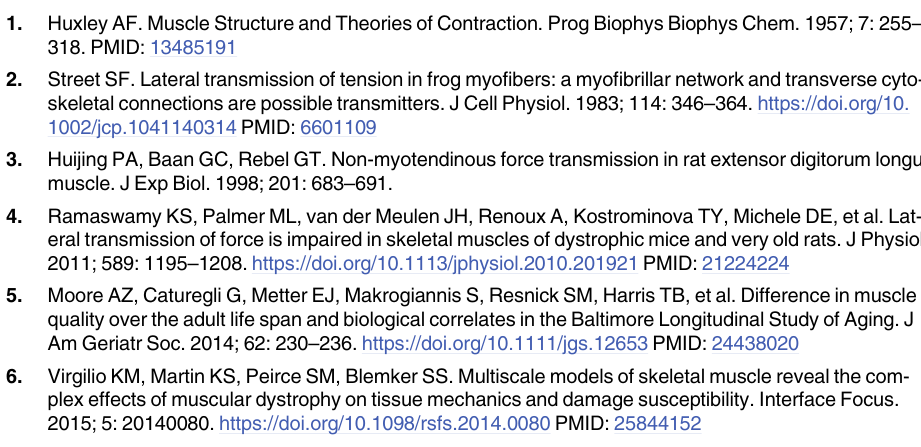
S3 Fig. Stress vs. sarcomere length experimental data. Stress vs. sarcomere length experi- mental data of pooled fast and slow fibres compared to numerical results obtained by the fit- ting equations proposed in the literature (see Eqs (4) and (5) in the main text of the present work). S1 File. Supporting data. Sarcomere length and tension for each fibre and